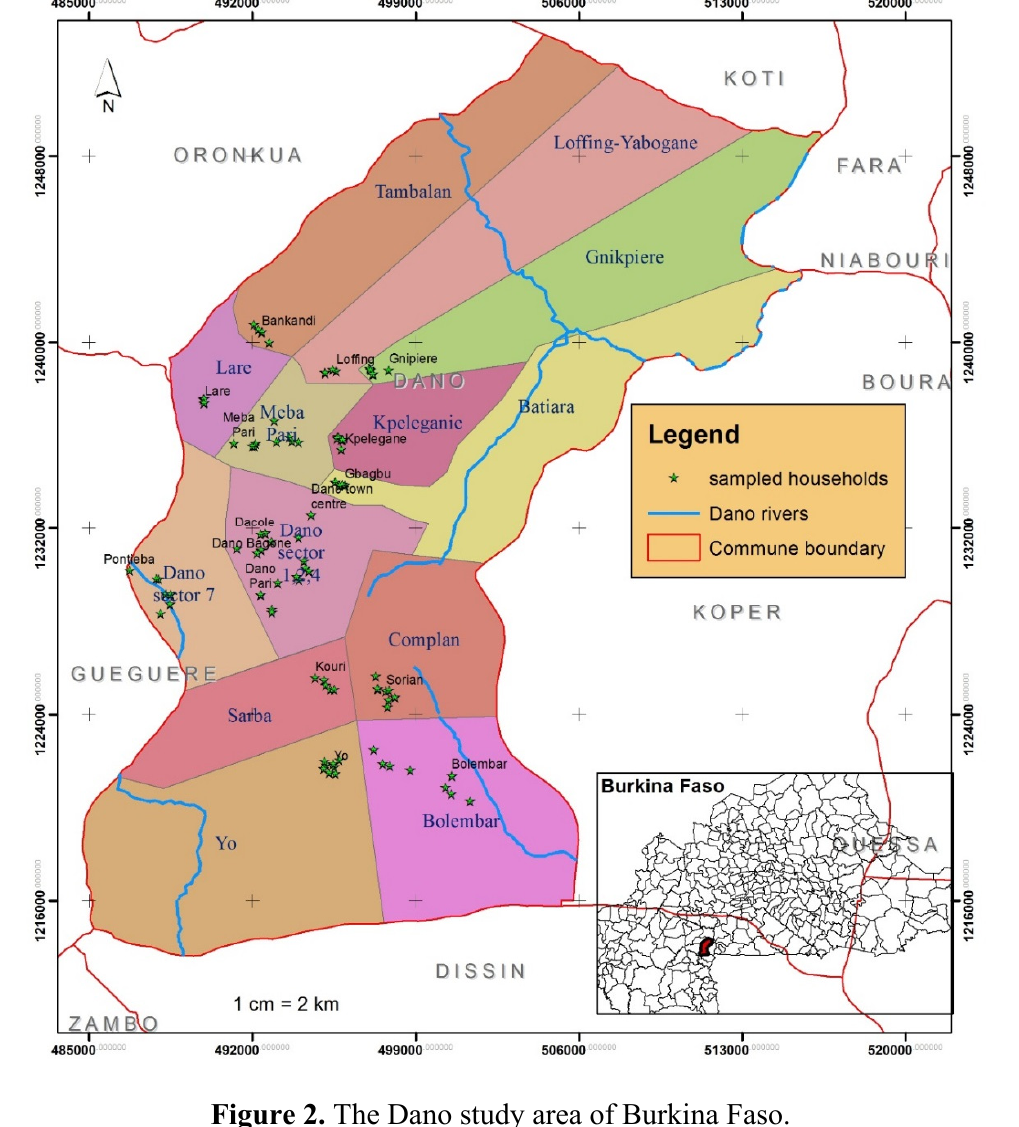
Figure 2. The Dano study area of Burkina